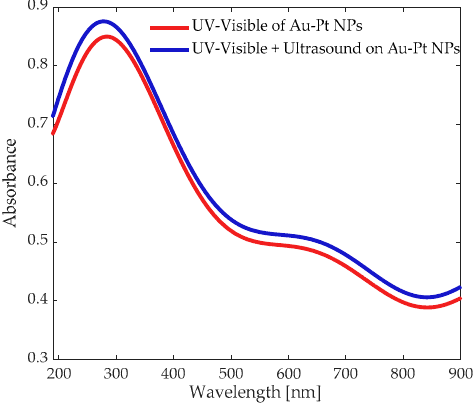
Figure 8. Representative UV-Visible absorption spectra of the studied samples showing a change derived by ultrasonic signals.